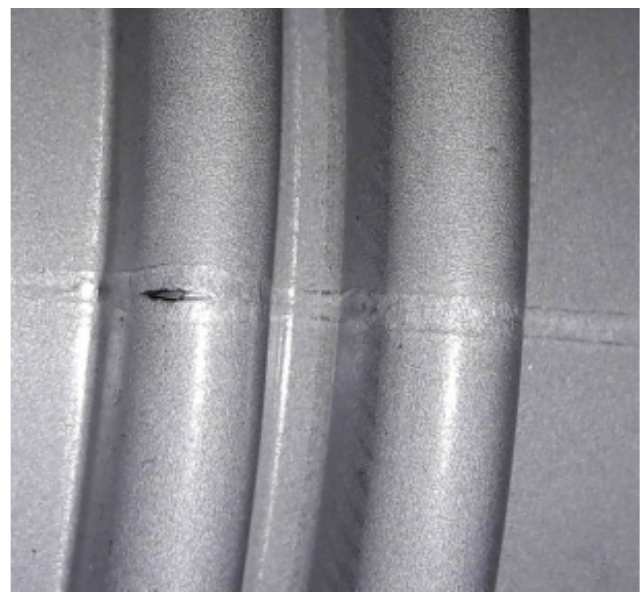
Figure 1. Destruction of the bellows expansion joint along the axis of the weld.